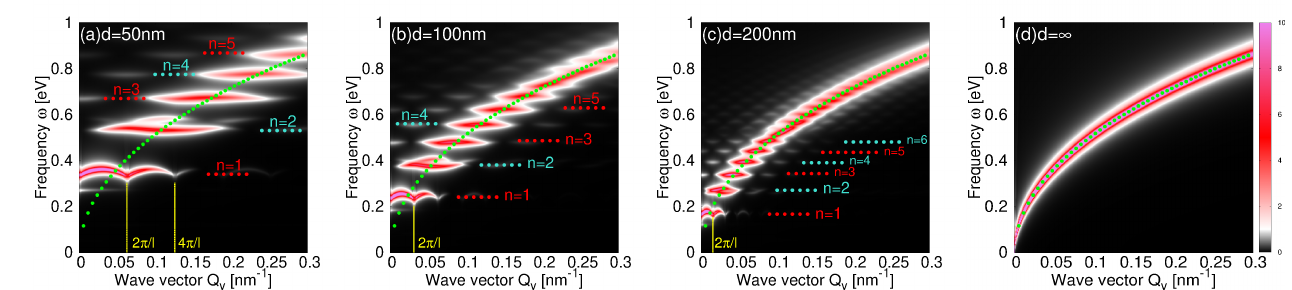
Figure 6. ( a – c ) The absorption intensity A (in units 2 π e 2 / h ) in the KC 8 -NR arrays of widths: ( a ) d = 50 nm; ( b ) d = 100 nm; ( c ) d = 200 nm. ( d ) The absorption intensity A in the KC 8 -SL. Red dotted lines denote the energies of the IR active modes n = 1,3,5, . . .. Turquoise dotted lines denote the energies of the dark modes n = 2,4,6 . . .. Structures are deposited on a dielectric model Al 2 O 3 surface. The nanoribbon period is l = 2 d and z 0 = 3.0 Å. Green dotted lines represent the DP dispersion in KC 8